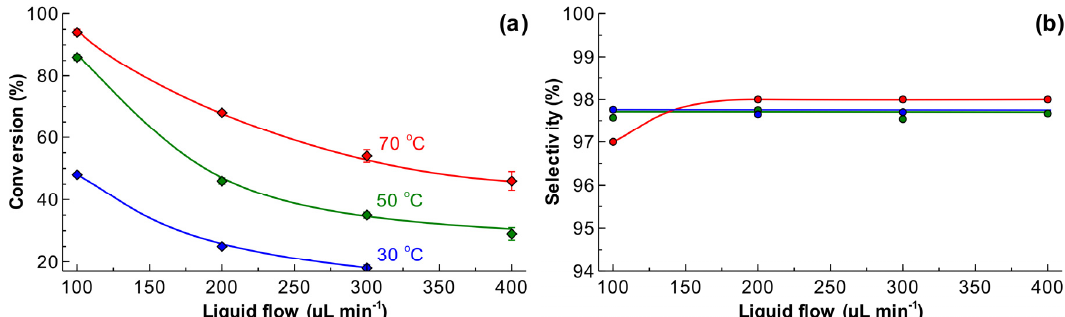
Figure 5. The effect of liquid flow rate and reaction temperature on ( a ) 2 ‐ methyl ‐ 3 ‐ butyn ‐ 2 ‐ ol (MBY) conversion and ( b ) 2 ‐ methyl ‐ 3 ‐ buten ‐ 2 ‐ ol (MBE) selectivity in semihydrogenation of solvent ‐ free MBY. Reaction conditions: MBY/H 2 molar ratio of 1.05, ambient H 2 pressure inside a 5 m reactor coated with a 5 wt% Pd/ZnO catalyst.